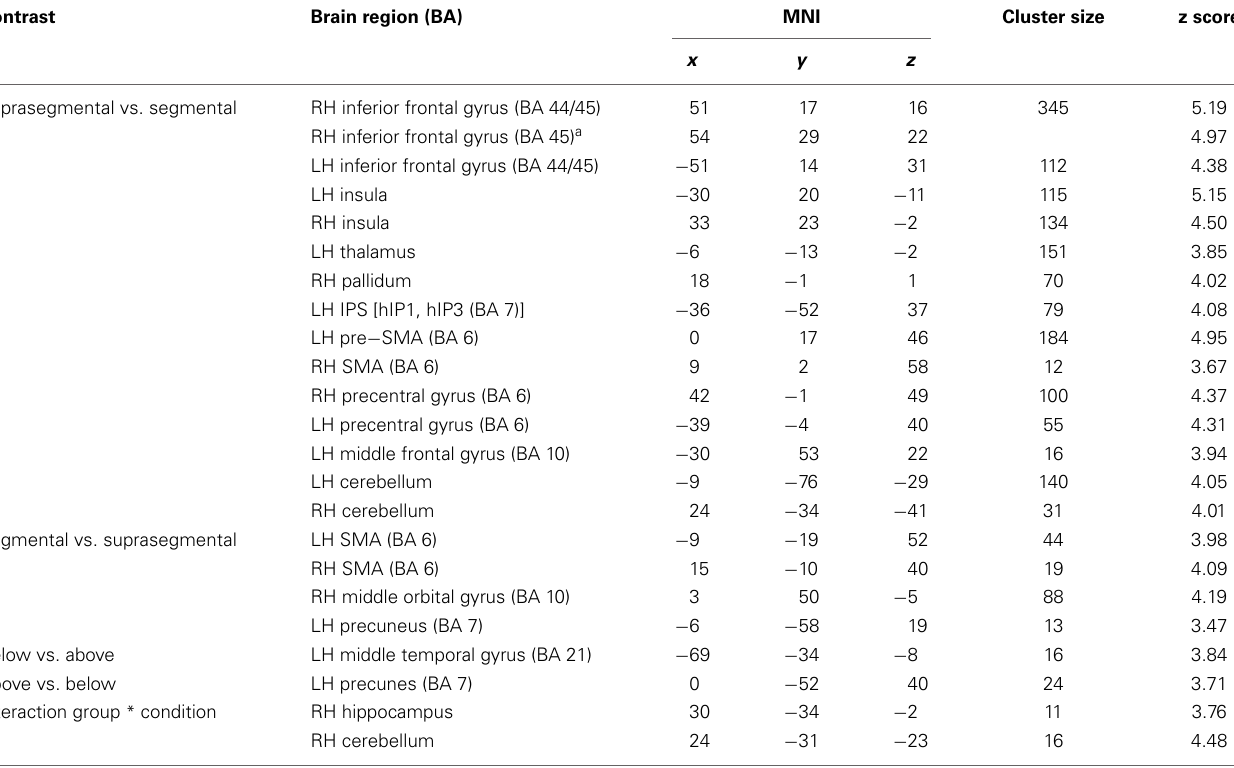
Table 3 | Significant brain activation differences for various group and condition